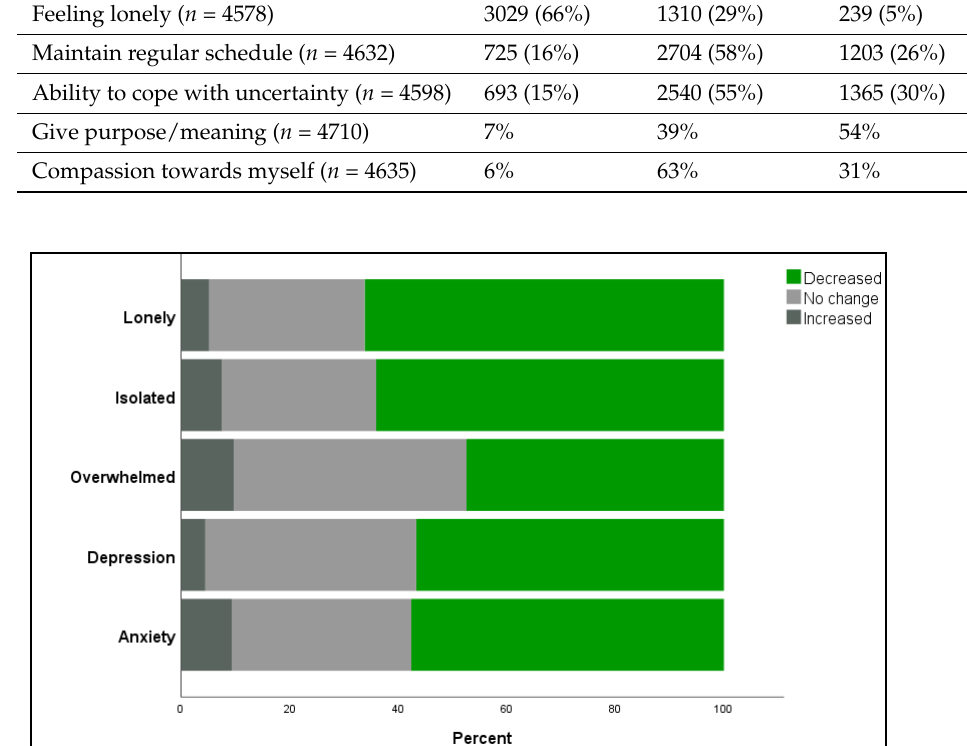
Figure 1. Reported impact of companion animals on COVID-19 related negative feelings.